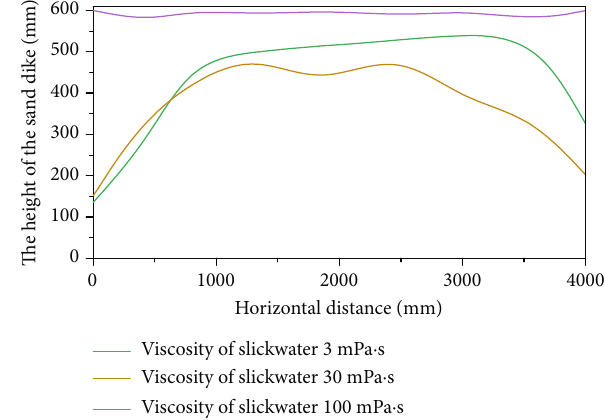
0 0 Figure 7: The height of the sand dike in sand carrying by slickwater with di ff erent liquid viscosities.